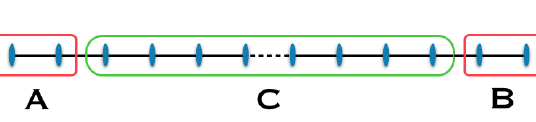
Figure 7: Tripartition of a spin chain in three subsystems, where the separated regions at the edges, A and B , are both made by two